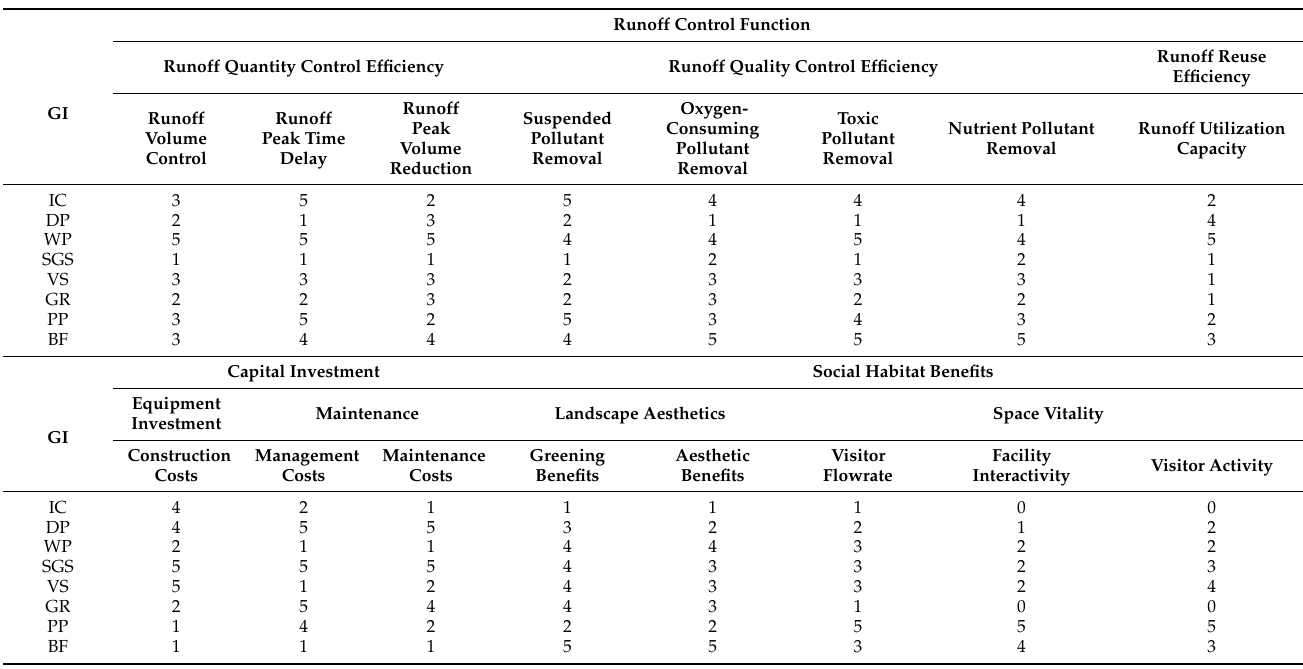
Table 4. The multifunctional evaluation scores for